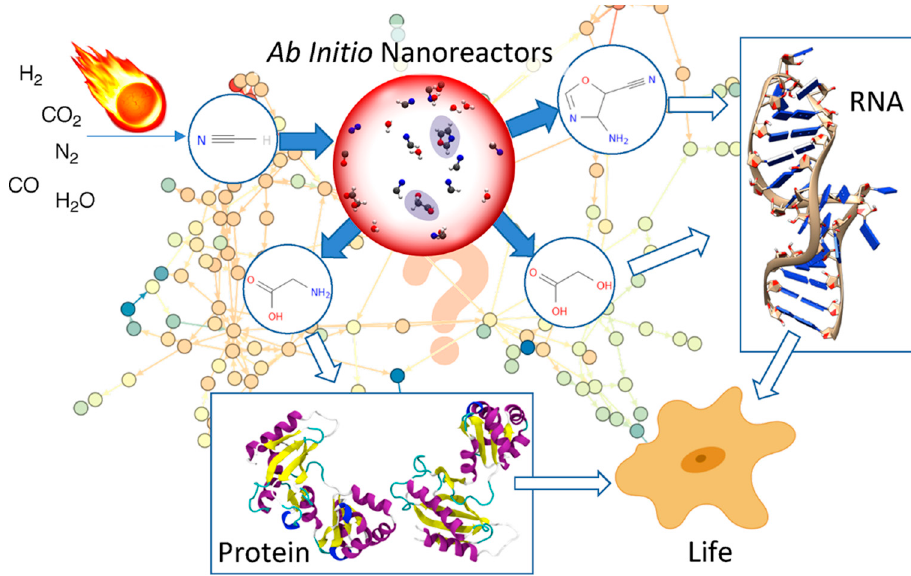
Figure 1. The synthesis of life relevant molecules (RNA, proteins) starting from inorganic materials and leading to the onset of chemical evolution. Figure reproduced from Ref. [70] https://pubs.acs.org/doi/10.1021/acscentsci.9b00832; Copyright (2019) American Chemical Society, further permissions related to the material excerpted should be directed to the ACS.